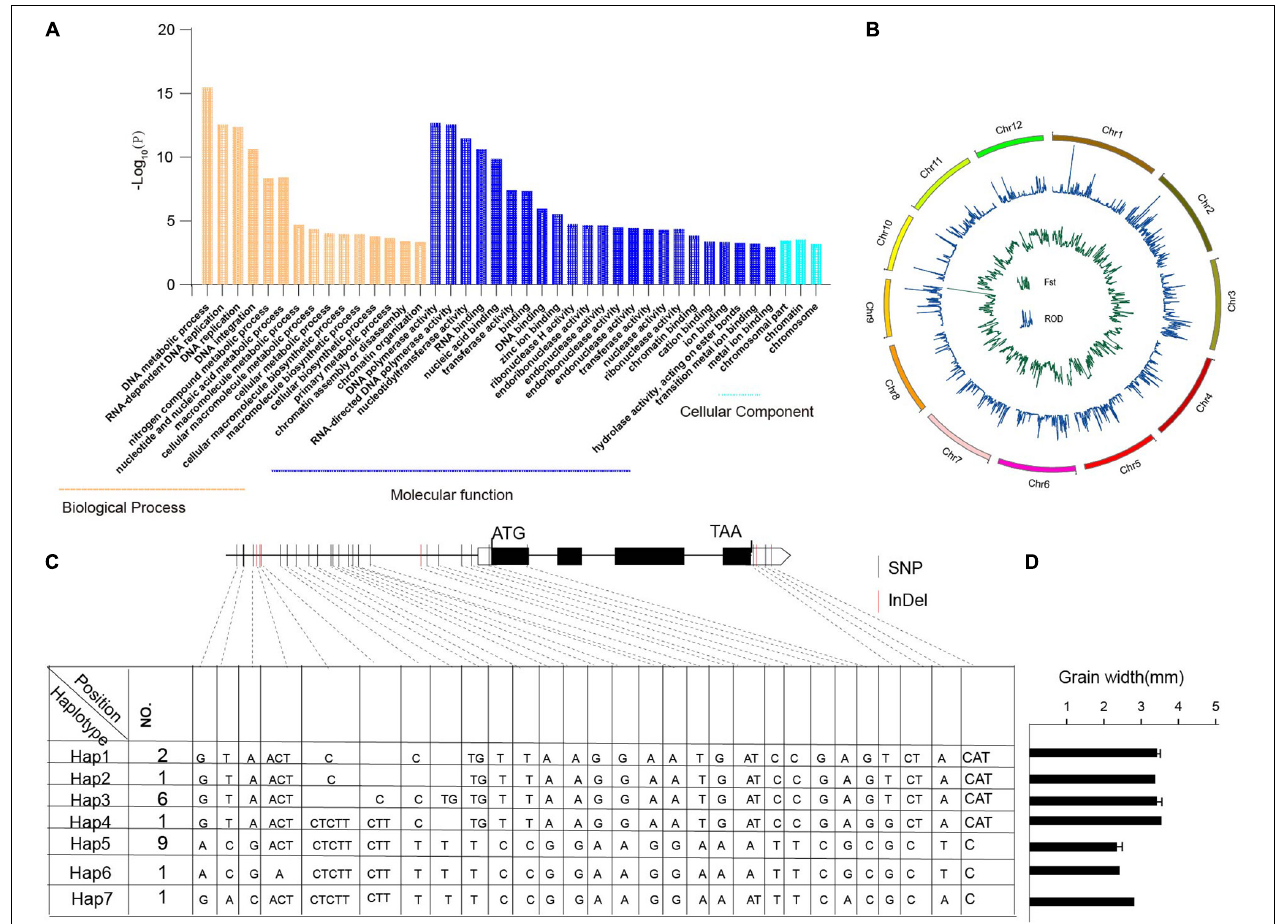
FIGURE 5 | Gene Ontology (GO) analysis of javanica private genes and haplotype analysis of TGW2 in 20 rice accessions. (A) GO enrichment analysis of the javanica private variation-associated genes. (B) . Selective sweep in the two subspecies. The green line indicates the reduction of diversity of two subspecies; the blue line shows fixation index of the two subspecies. (C) . Sequence and allelic variation in TGW2 among 20 rice accessions. Sequence and allelic variations in TGW2 including promoters and coding sequence (CDS) from 10 Oryza javanica and 10 improved indica cultivars were analyzed. Hap1–Hap6 represents six different haplotypes of TGW2 , and No. represents the number of rice accessions for each type. The position of start codon is considered as +1. In CDS region, the black box represents exons whereas the lines between boxes represent introns. Nucleotide polymorphisms are displayed at their corresponding positions. The black vertical line indicates SNPs while red vertical line stands for InDels. (D) The grain width of the sample which carried different haplotypes of TGW2. Hap7 was represented